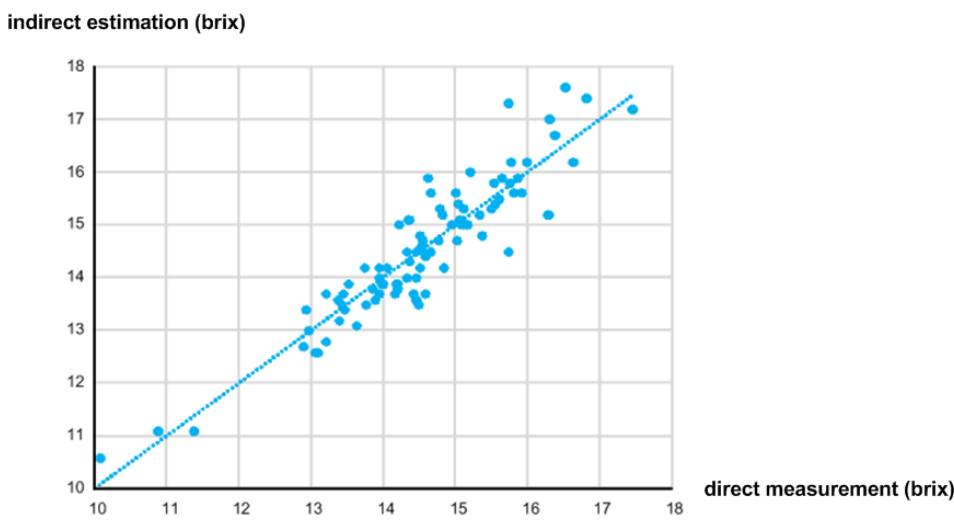
Figure 5. Correlation between indirect estimation and direct measurement of sugar content.